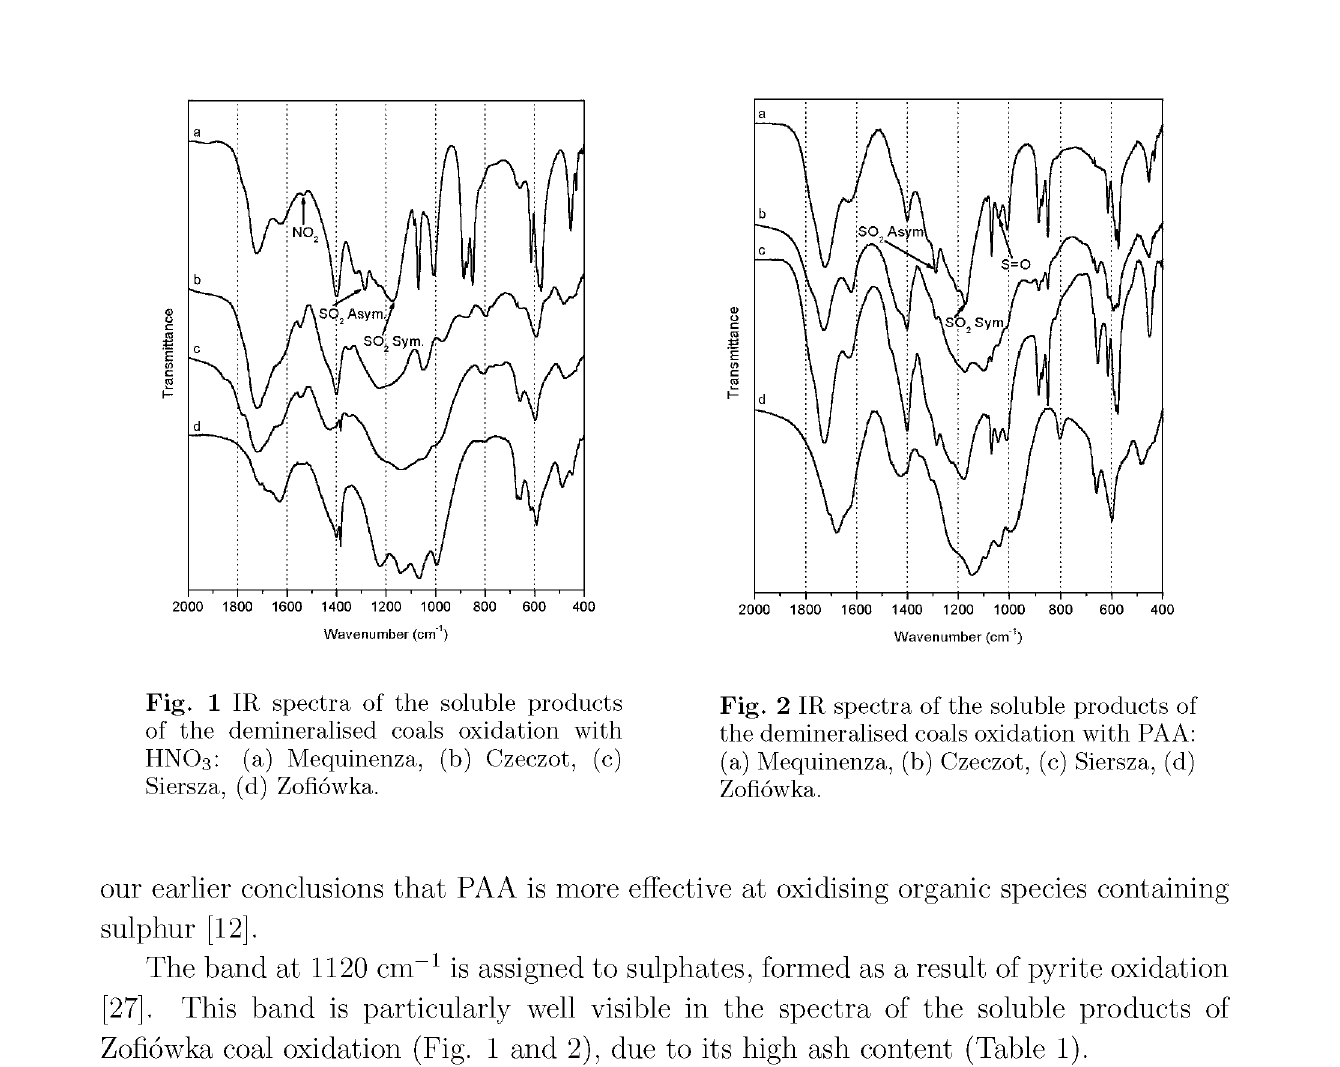
Fig. 2 IR spectra of the soluble products of the demineralised coals oxidation with PAA: (a) Mequinenza, (b) Czeczot, (c) Siersza, (d)